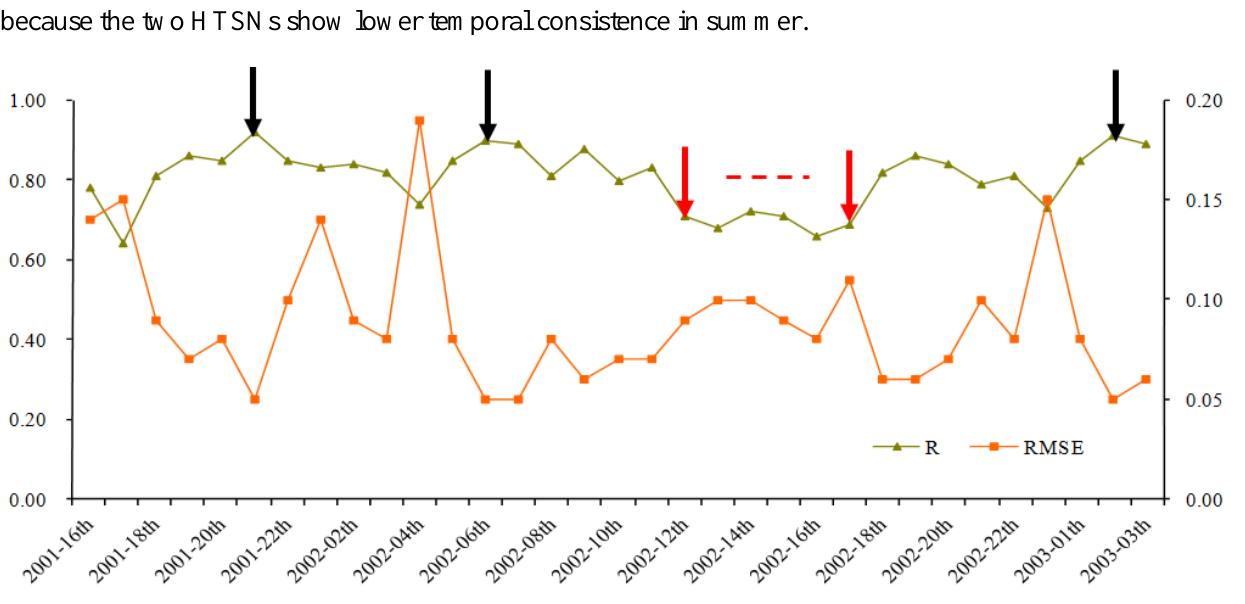
Figure 6. The temporal curve of R between two HTSNs synthesized by two different schemes. Three composites with high correlation coefficients are decentralized in all seasons except summer. The highest correlation coefficients marked with black arrows above 0.9 are respectively corresponding to the 21st composite of 2001 (winter, R = 0.92), the second composite of 2003 (winter, R = 0.91), and the sixth composite of 2002 (spring, R = 0.90). The lower correlation coefficients marked with red arrows are corresponding to the 12th through the 17th composites in summer of 2002.